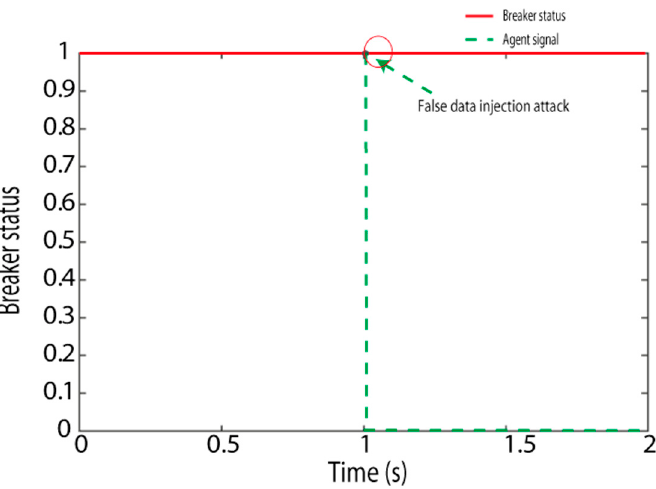
Figure 6. Electrical Current during single-line-to-ground fault.